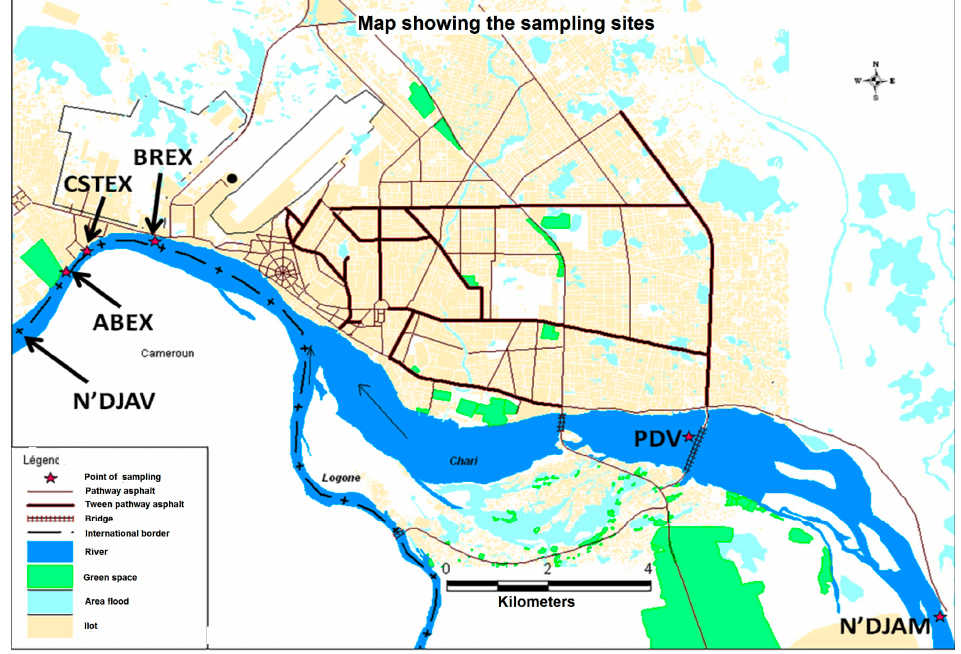
Figure 1. Map of N’Djamena showing the sampling sites: PDV: The bridge in Ndjamena; BREX: Discharge from the Chad breweries (BR). The Chad breweries are located 20 km from the PDV; CSTEX: Discharge from the national Chad Sugar Company (CST). It is located 2 km from BREX; ABEX: Discharge from the slaughterhouse/modern meatpacking plant. It is located 2 km from CSTEX; ABAV: Site located 75 meters downstream of the slaughterhouse